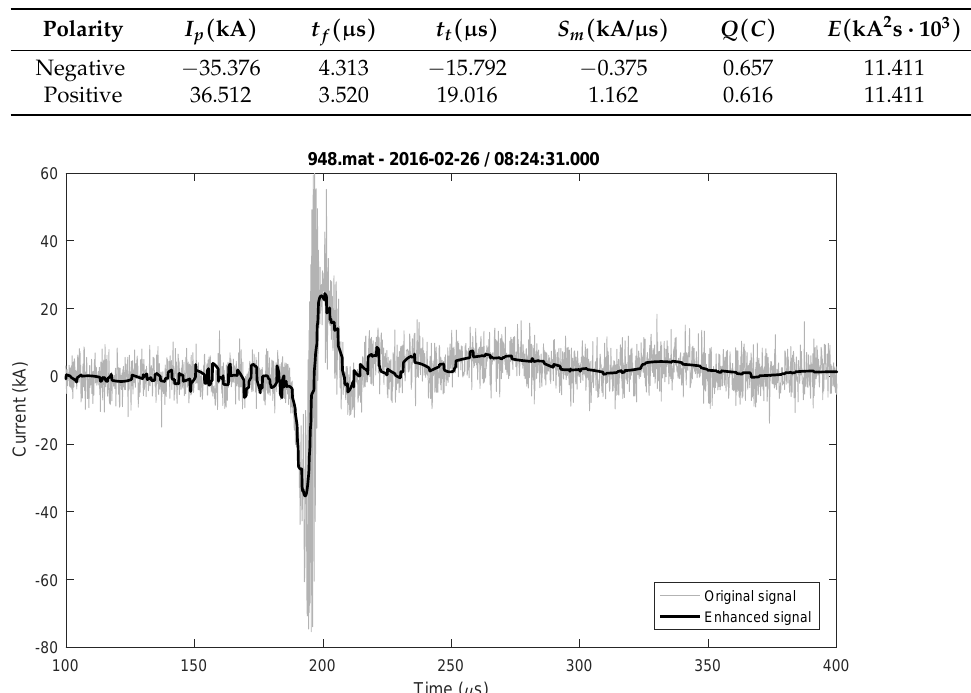
Table 11. Parameters for recorded bipolar flash.